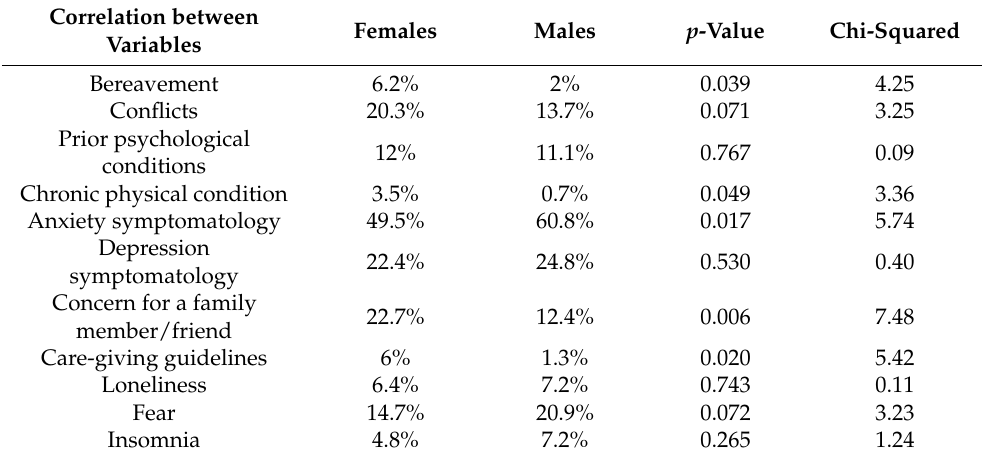
Table 2. Cross-tabulation of variables with gender.